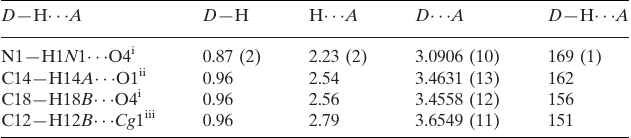
Hydrogen-bond geometry (A˚ , (cid:2) ). Cg 1 is the centroid of the C1–C6